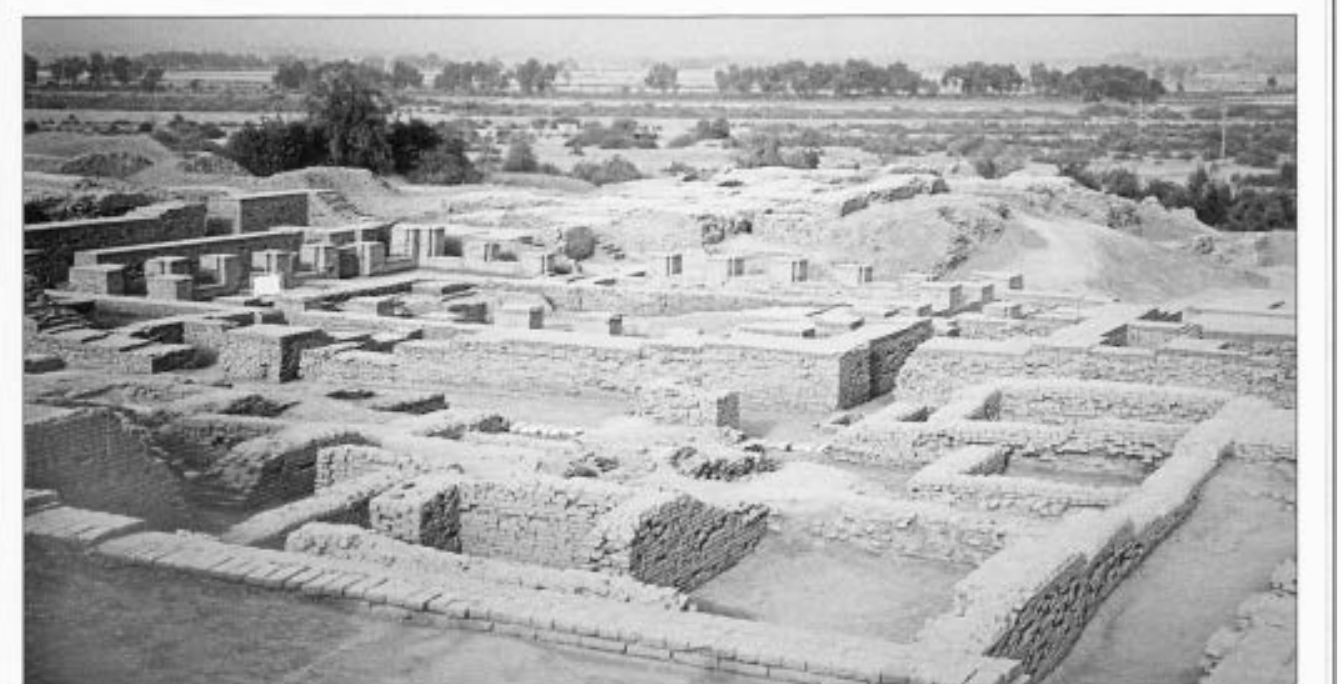
Figure 2 General view of Mohenjo-daro, a site of the Indus Valley civilization,